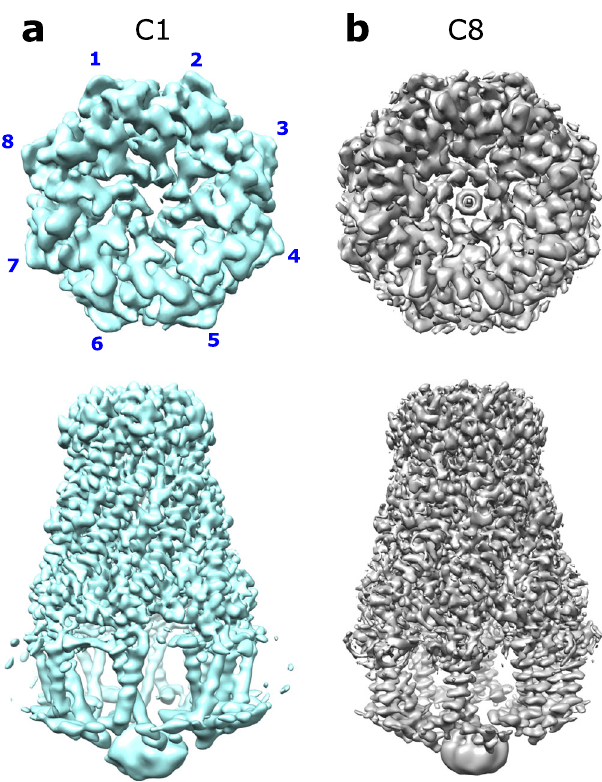
Fig. 1 Overall structure of E. coli WzzB. Final reconstructed volumes of the full-length WzzB re fi ned without ( a ) and with ( b ) the application of C8 symmetry. Top: view looking down from the top of the periplasmic